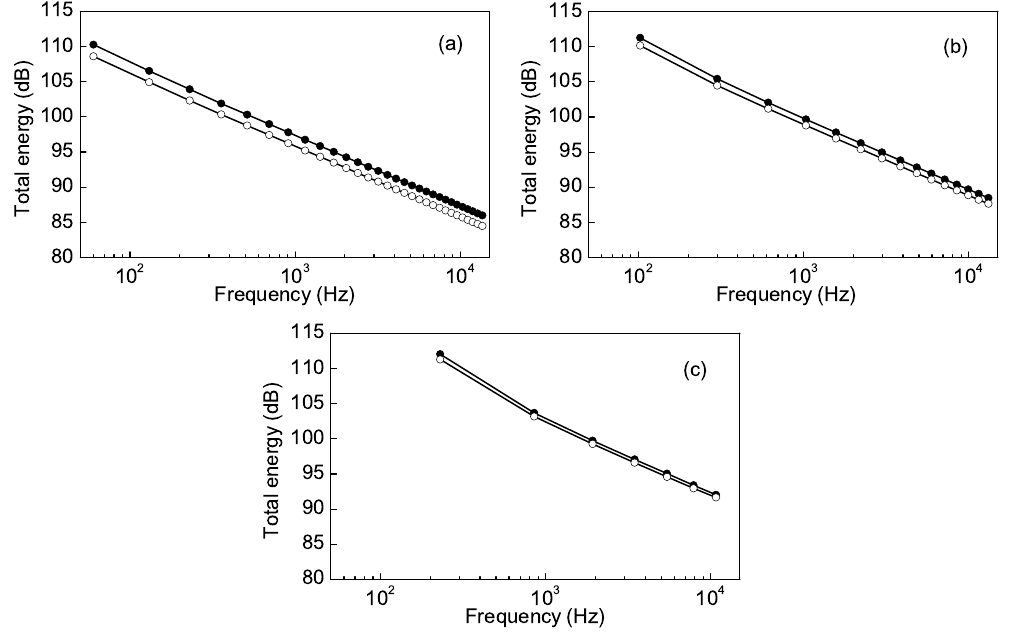
Fig. 6. Total energy response of a beam subject to random distributed force: - • -, exact total energy response; - ◦ -, approximate total energy response. Each frequency band contains: (a) 5 modes; (b) 10 modes; (c) 20 modes. The reference energy is 1 × 10 − 12